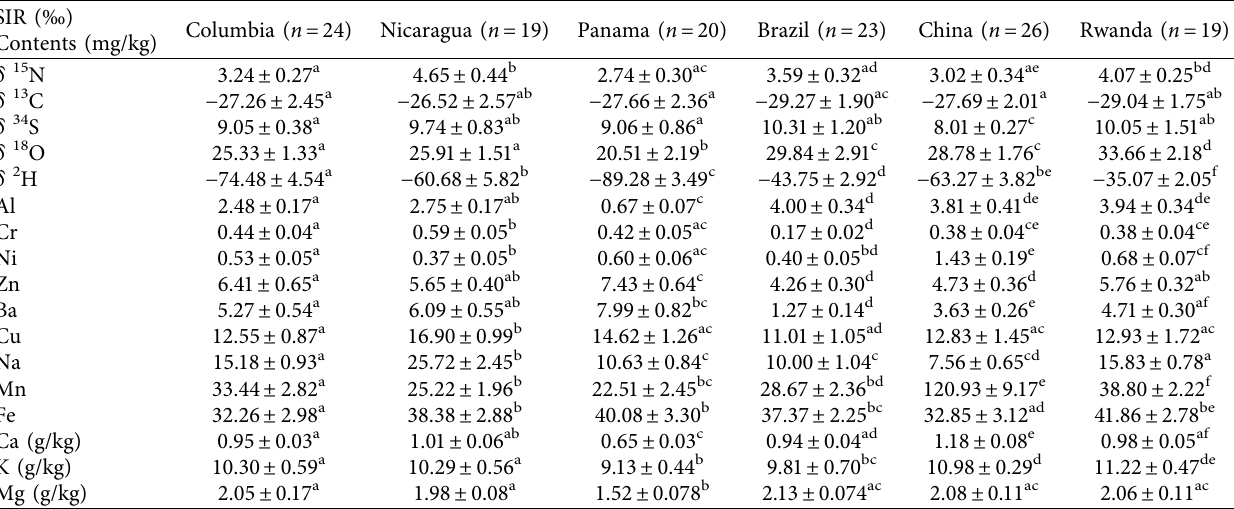
Table 8: Te mean ± standard error value of fve stable isotopes and twelve elements of dark roasted beans from six diferent origins. SIR (‰)